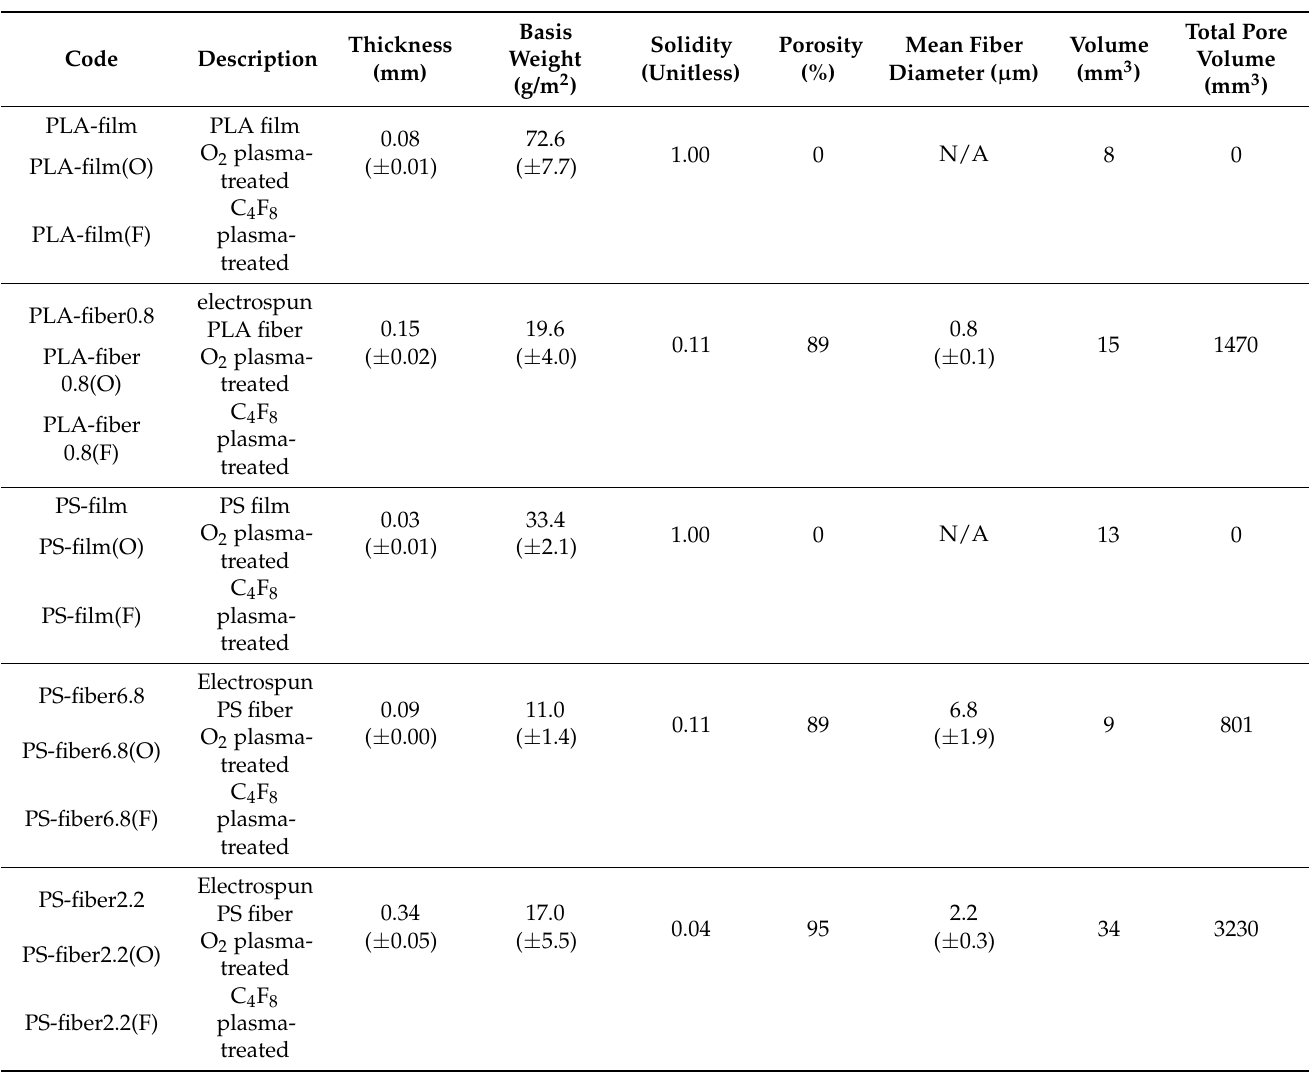
Table 1. Substrate sample description and